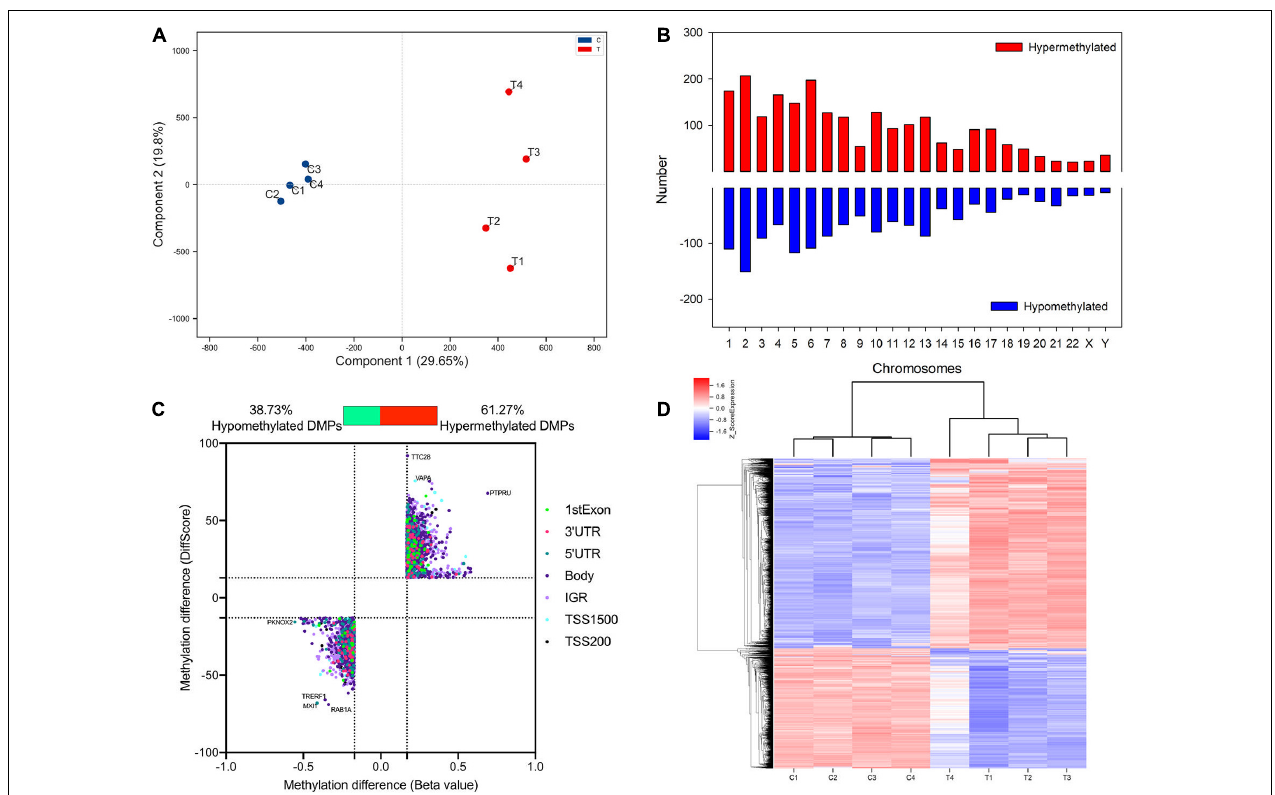
FIGURE 1 | Identification and qualification of differentially methylated probes. (A) PCA analysis of methylation in TAO cases and controls. (B) Distribution of TAO-associated DMPs across chromosome. (C) Scatter plot of hyper- and hypo-DMPs based on threshold of | DiffScore| > 13 and | Beta value| > 0.17. (D) Heatmap of hierarchical clustering analysis for samples according to